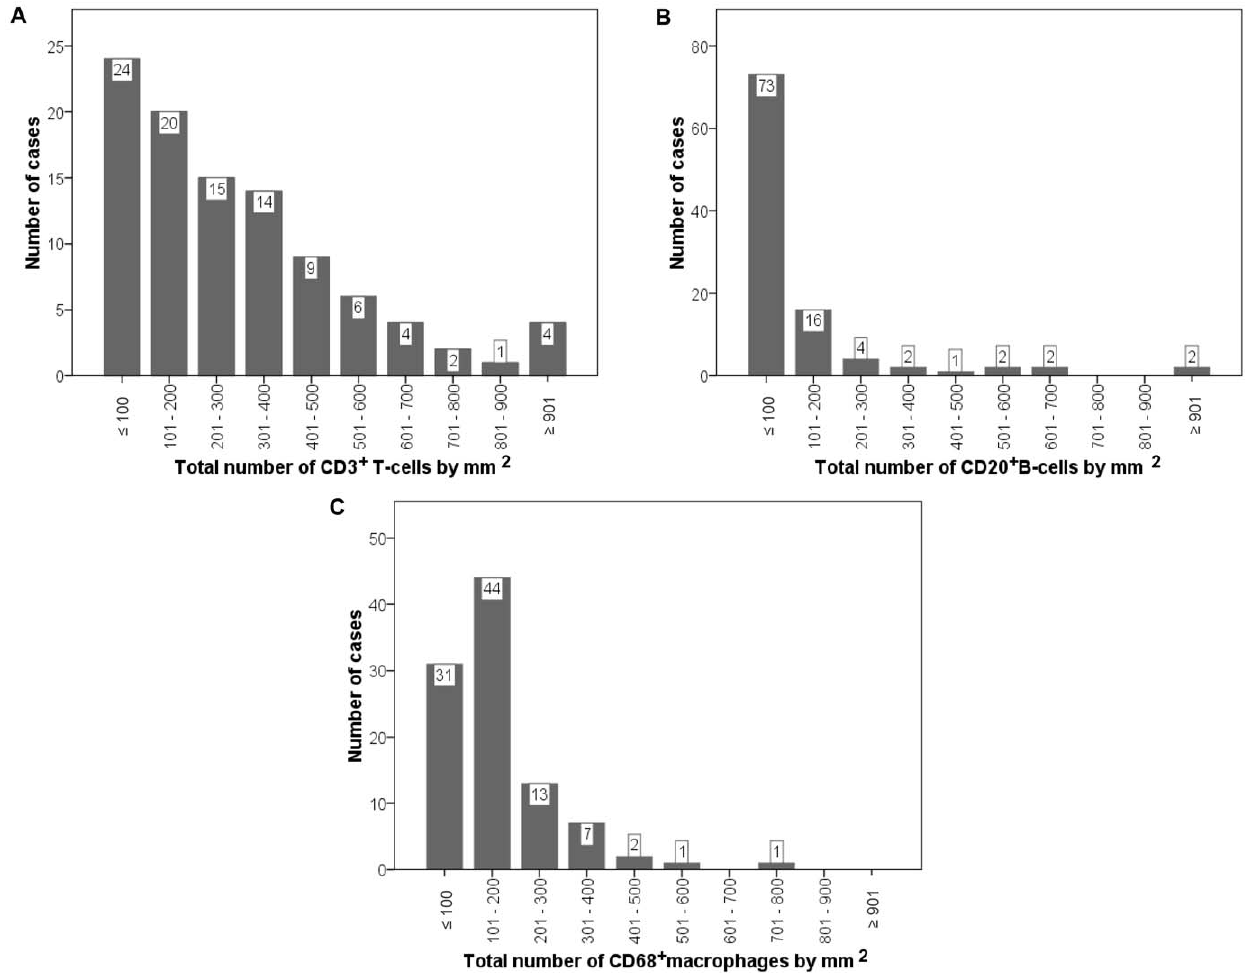
Figure 2. Distribution of the total number of CD markers by mm 2 at the invasive front, in 102 breast carcinomas. CD3 (A), CD20 (B) and CD68 (C).